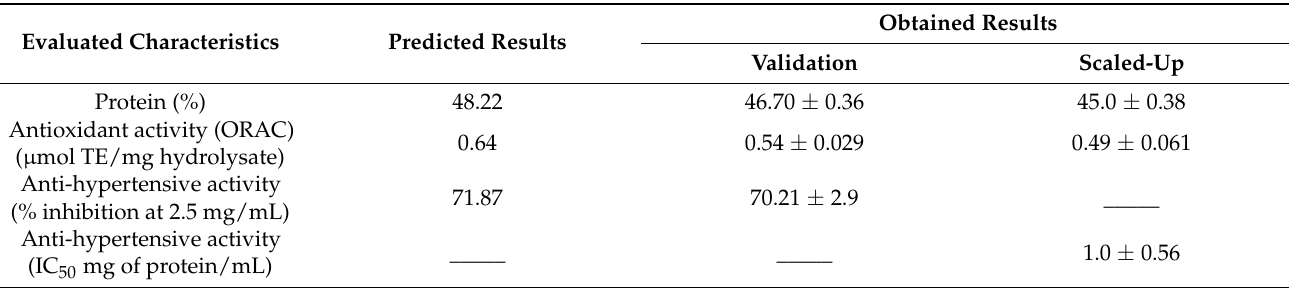
Table 6. Results predicted by the model, and results obtained in a validation and a scaled-up enzymatic hydrolysis, performed with the optimal conditions described in Table